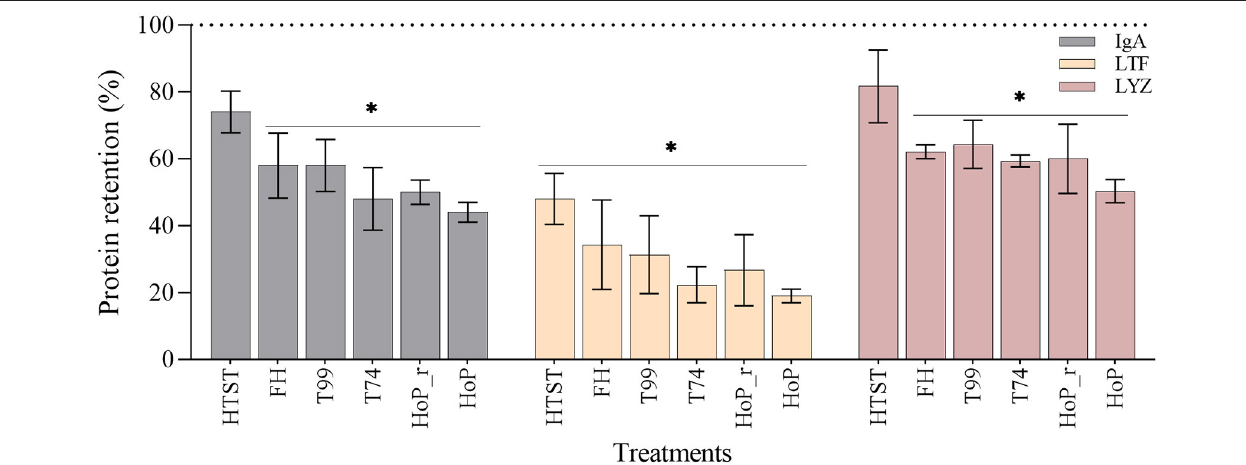
FIGURE 5 | Effect of HTST, FH, T99, HoP_r, T74 and HoP on the IgA, LTF and LYZ content. Protein retention (%) was calculated based on the iBAQ intensities obtained by LC-MS/MS. The dotted line represents the untreated values (100%). The analyses were performed in duplicate for each sample and all values are presented as mean ± standard deviation of two independent experiments. *Expresses statistically significant differences to untreated samples ( p < 0.05). UN, HTST, FH, T99, T74, HoP and HoP_r stand for untreated DHM, and DHM treated with high-temperature short-time, flash heating, high-temperature short-time with a thermomixer preheated at 99 ◦ C, high-temperature short-time with a thermomixer preheated at 74 ◦ C, holder pasteurization and holder pasteurization with rapid heating up-times, respectively.